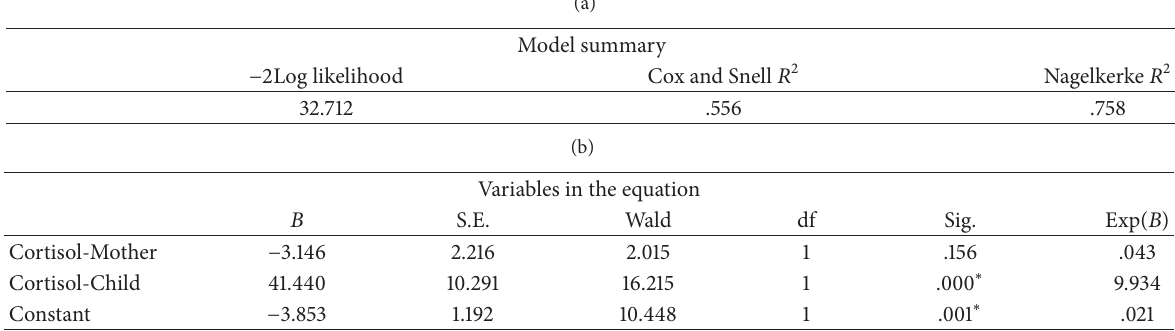
Table 4: Binary logistic regression model using the presence or absence of ECC as exposure factor and salivary cortisol levels of the mother and the child as